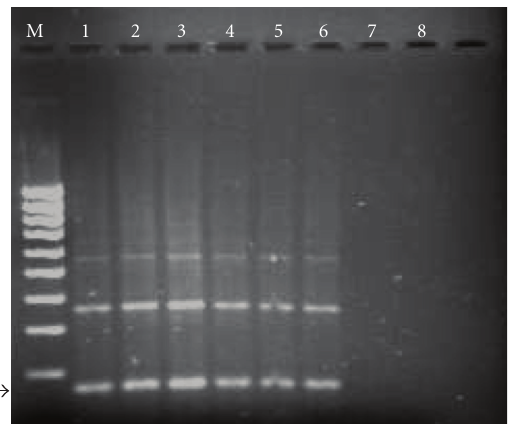
Figure 3: Molecular-based assay: PCR. Example of PCR results obtained for seven monkey samples, using the TCRUZ primers. Blood samples were processed as described in Materials and Methods. The PCR products were electrophoresed in a 2% agarose gel and stained with ethidium bromide. The 168 bp band (arrow) is the expected T. cruzi -specific product. The 360 and 550 bp are also specific products resulting from amplification of two or three of the 195 bp repeats found in tandem arrays in the T. cruzi genome. Lanes 1 to 6 contain the amplification products of DNA from T. cruzi- infected monkeys; 7, blood from noninfected monkey; 8, negative control (distilled water); and M, 100 bp ladder, adapted, with permission of Comparative Medicine from